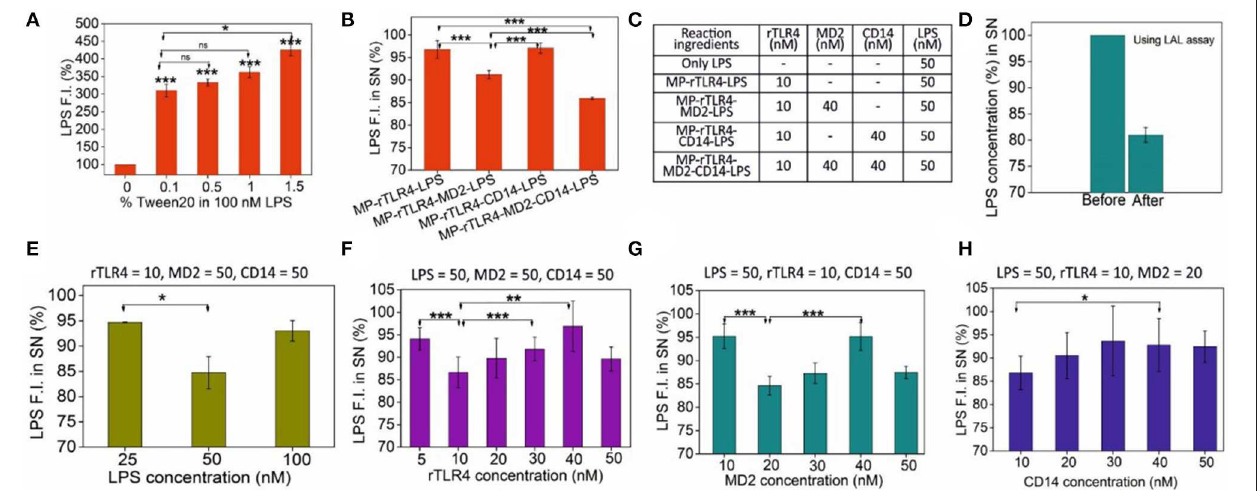
FIGURE 3 | (A) LPS monomerization aided by surfactant Tween 20 addition. (B) The importance of CD14 and MD2 on the extent of complexation, and (C) the molar amounts of molecules used in these reactions. (D) Cross-validation of LPS capture using the LAL assay. (E–H) Sequential scouting experiments: Bulk concentrations of LPS (E) , rTLR4 (F) , MD2 (G) , and CD14 (H) were optimized one-by-one and the optimized values were fixed in all the subsequent experiments to get maximum LPS capture efficiency at each step. The fixed concentration values of the remaining reagents (all in nM) are listed on top of each graph. All experiments were performed in 0.5% PBST, pH 7.4 ( n = 3) (SN = supernatant, ns, p > 0.05, * p = 0.01–0.05, ** p = 0.001–0.01, *** p <